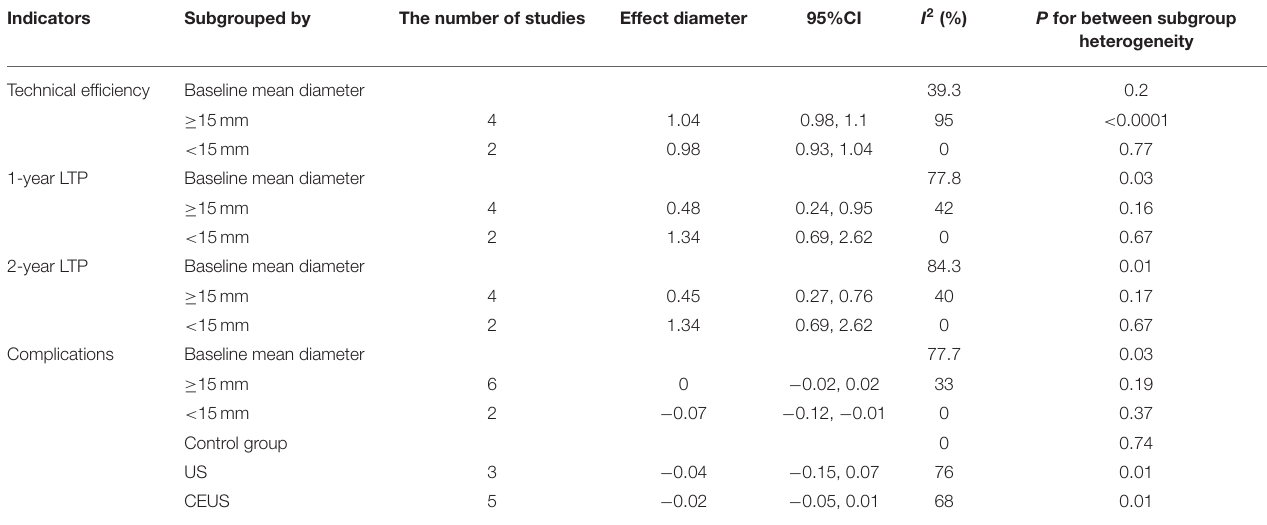
TABLE 4 | Subgroup analysis to assess the effects of ultrasonic image fusion on radiofrequency ablation. Indicators Subgrouped by The number of studies Effect diameter 95%CI I 2 (%) P for between subgroup